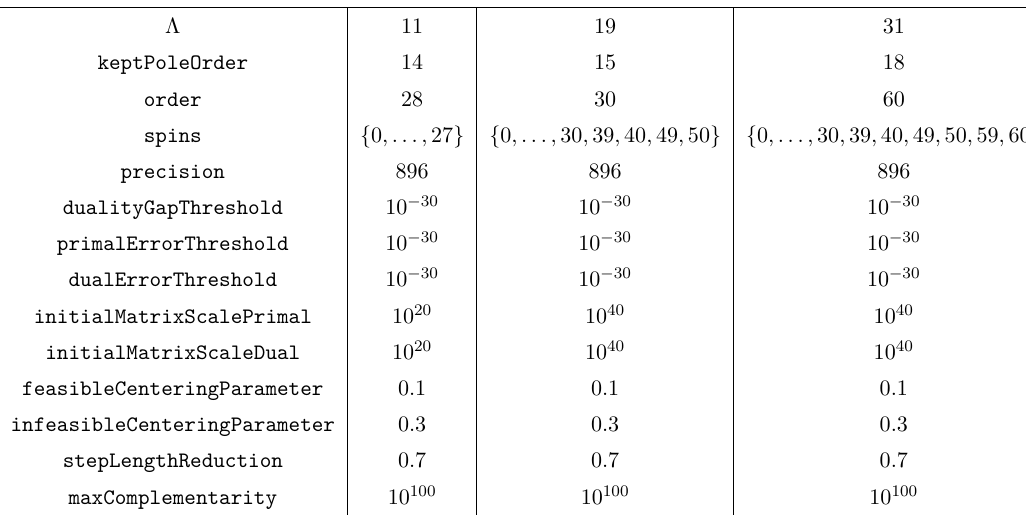
Table 7 . Parameters used to setup the SDPs, along with the SDPB parameters. The definition of these can be found in [10] (where order was 90 and keptPoleOrder was κ